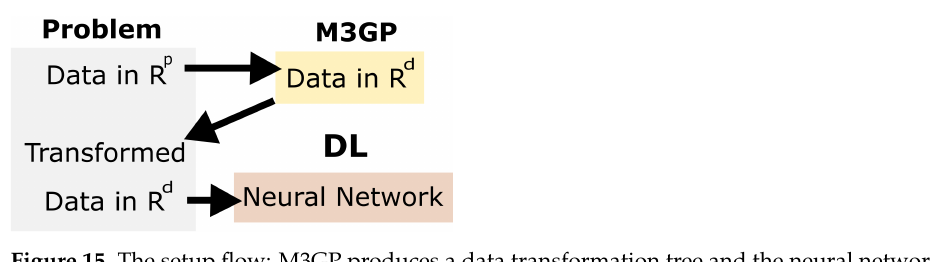
Figure 15. The setup flow: M3GP produces a data transformation tree and the neural network runs with the new data in R d